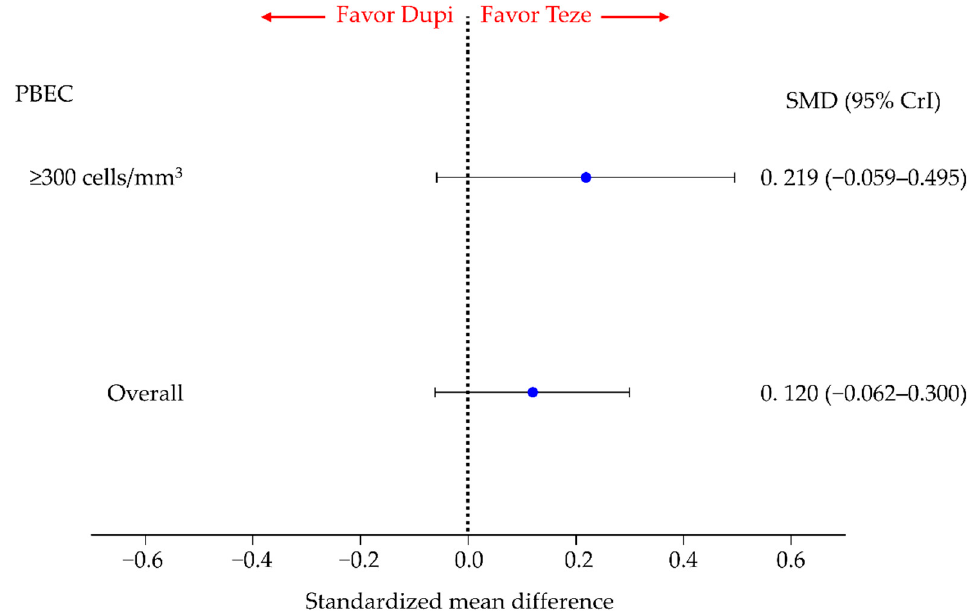
Figure 6. Comparative efficacy of tezepelumab and dupilumab in terms of the change in the AQLQ score in patients with inadequately controlled asthma in overall participants and subgroups stratified by PBEC thresholds. Comparisons are expressed as tezepelumab versus dupilumab. Data are expressed as standardized mean differences (SMDs) and 95% credible intervals (CrIs). AQLQ, Asthma Quality of Life Questionnaire; Teze, tezepelumab; Dupi, dupilumab; PBEC, peripheral blood eosinophil